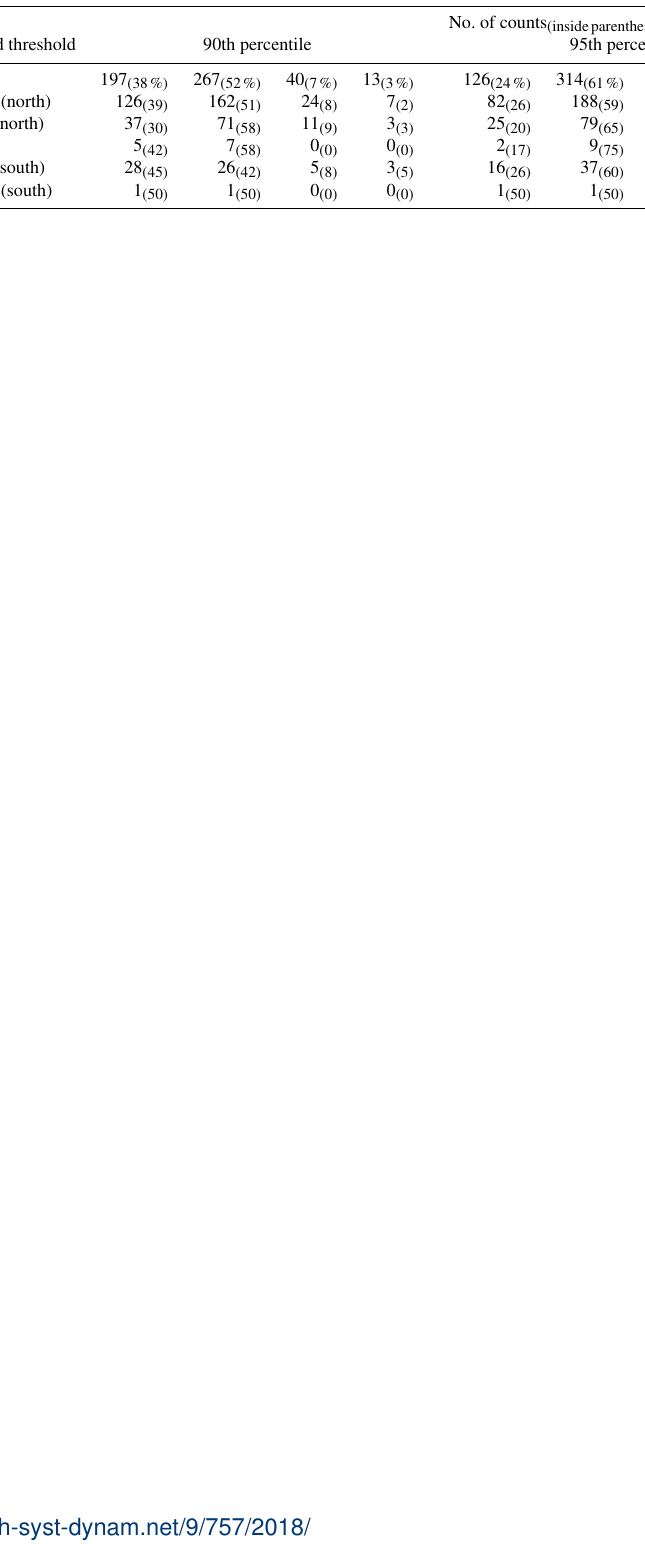
Table B2. Comparing flood duration ( F D ) reported by the DFO and calculated from the GRDC ground-based observations for the global scale and over five latitudinal belts. Three flood-related exceeding thresholds (i.e., 90th, 95th, and 99th) are derived from the entire daily observations of the GRDC stations located adjacent to the centroid of the flood event reported by the DFO. Spatial scale F { DFO }